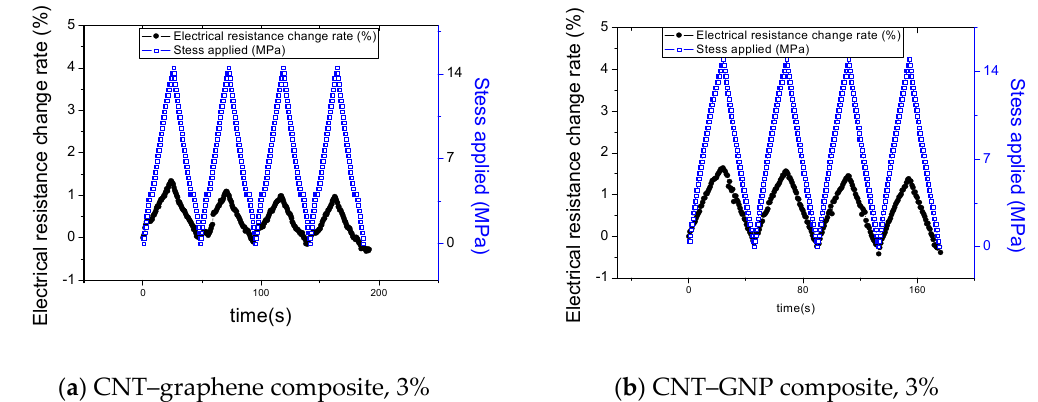
Figure 6. Electrical resistance change rates and applied stress change curve of composites determined with the lapse of time under repetitive tensile loadings: ( a ) the epoxy-based composites incorporating 3% CNT–graphene and ( b ) the epoxy-based composites incorporating 3% CNT–GNP (Piezoresistive responses of other composite types can be found in Figure S4).